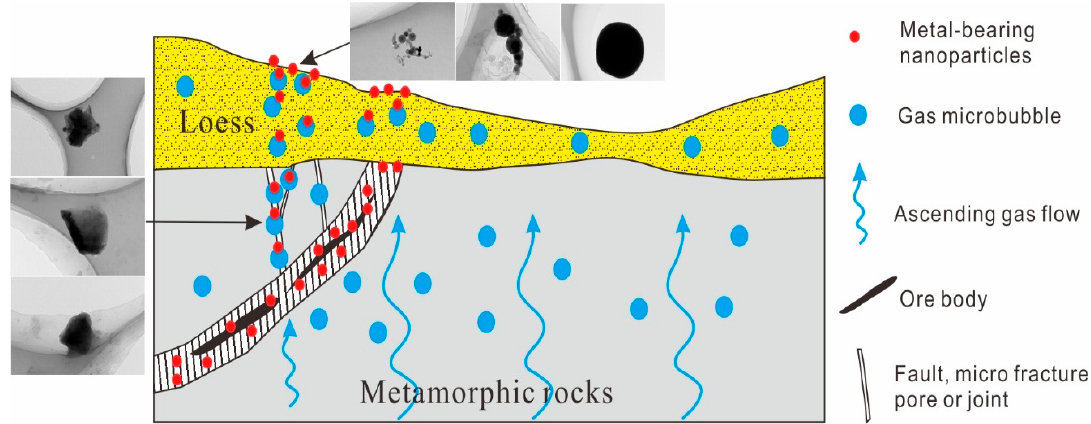
Figure 12. Schematic diagram of the migration model of the metal-bearing nanoparticles.